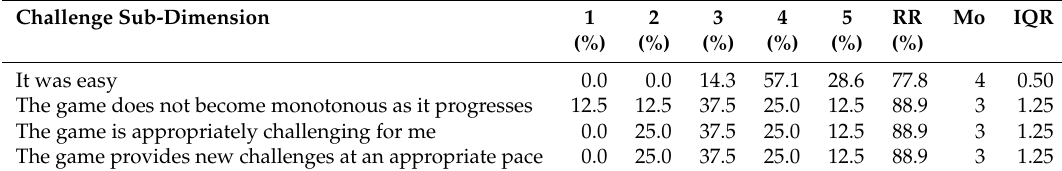
Table A1. MARISA Game feedback—Challenge.